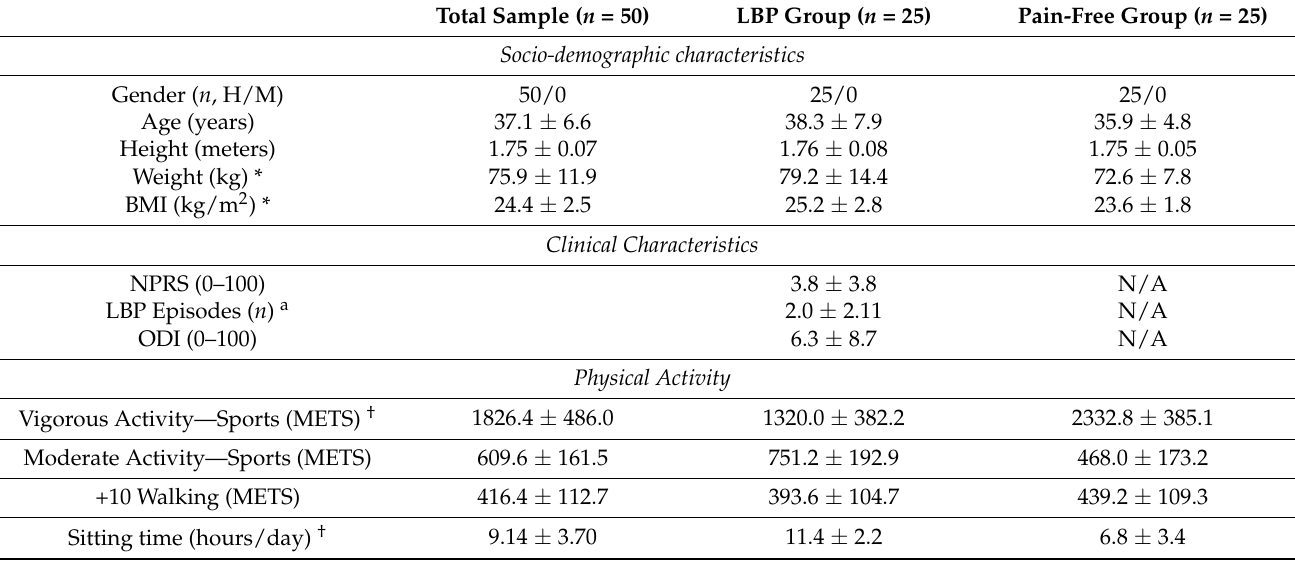
Table 1. Baseline characteristics of the sample by group.